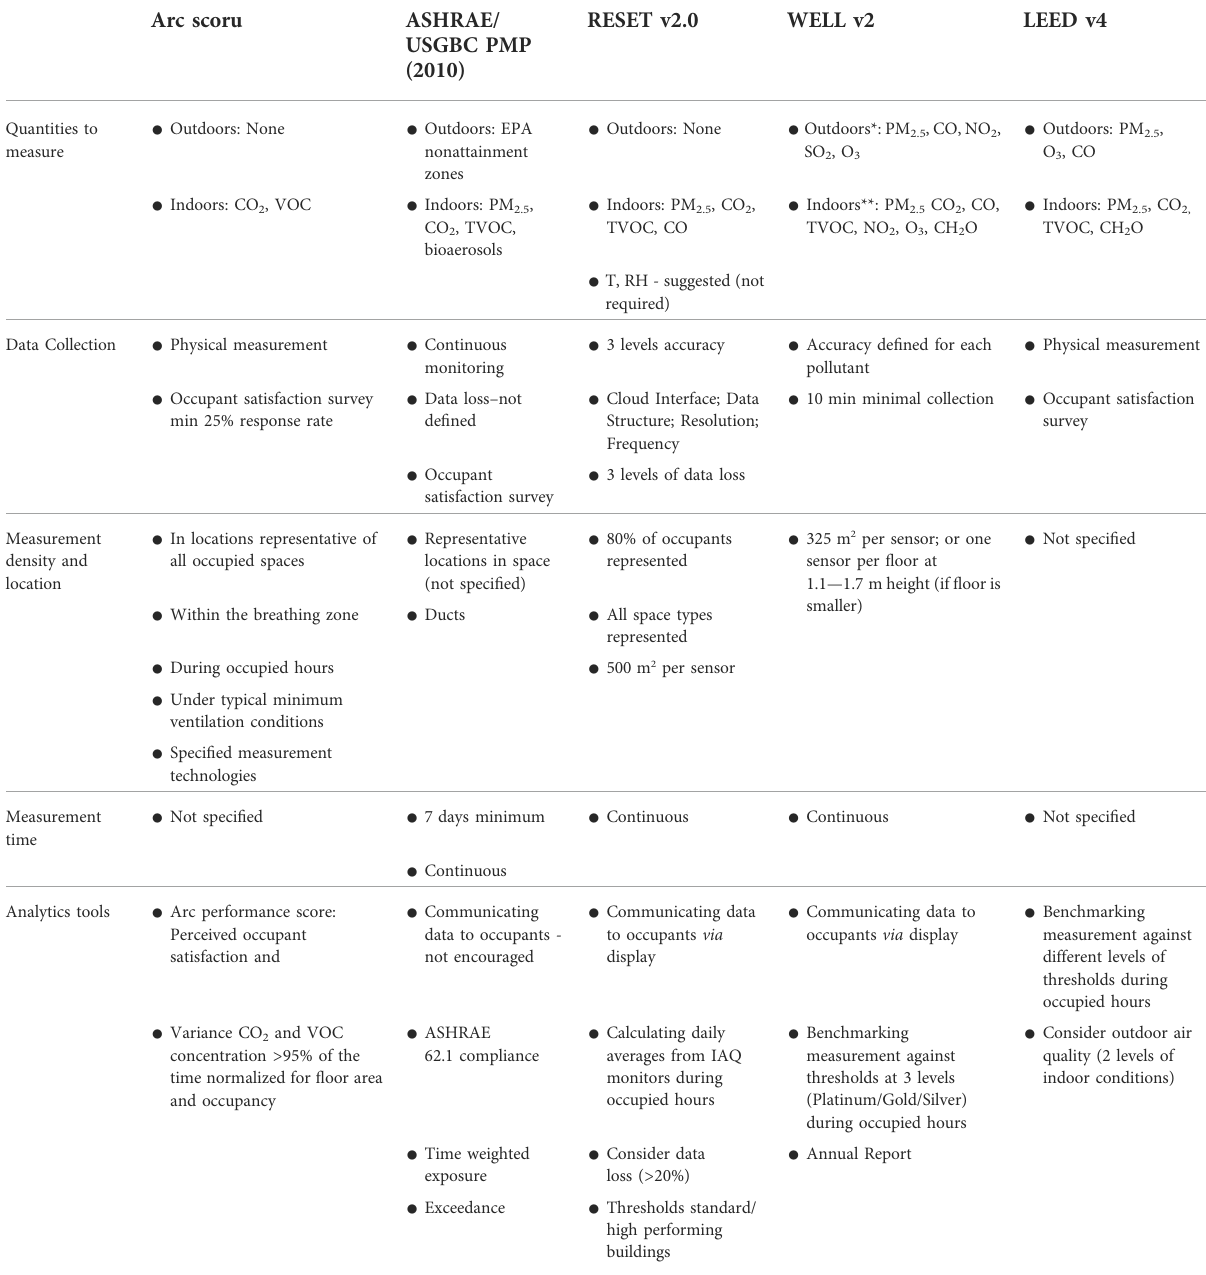
TABLE 1 Summary of guidelines/standards available for deployment of air quality sensors for continuous monitoring in